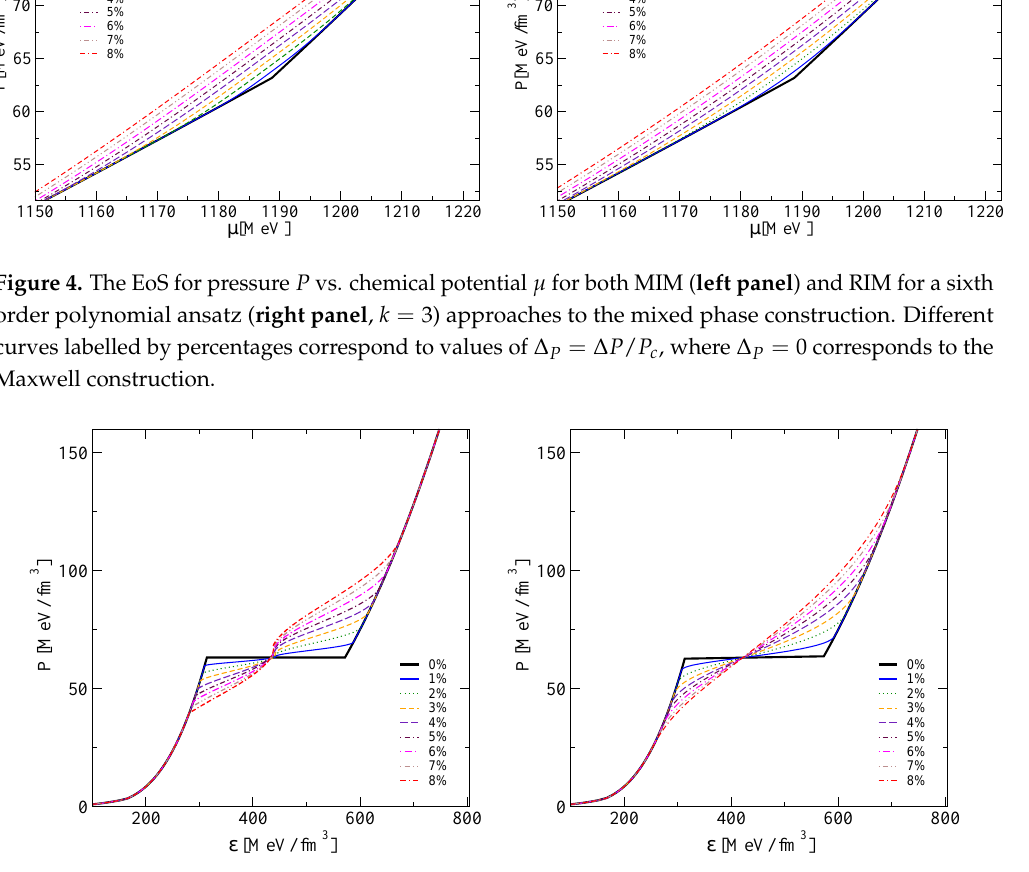
Figure 5. The EoS for pressure P vs. energy density ε for both MIM ( left panel ) and RIM for a sixth order polynomial ansatz ( right panel , k = 3) approaches to the mixed phase construction. Different curves labelled by percentages correspond to values of ∆ P = ∆ P / P c , where ∆ P = 0 corresponds to the Maxwell construction. See [23] for an extended discussion on the MIM approach.